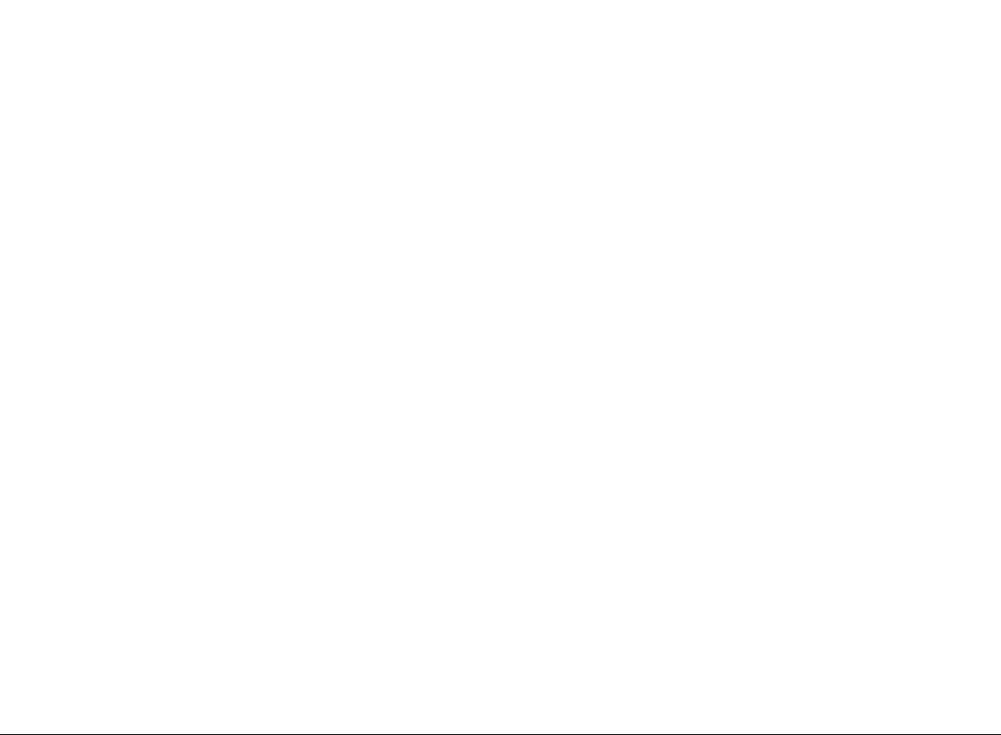
in Figure 4 of the main text, and gradiometer locations with peak signal.) (B) Mean regression coefficients when cue direction and HEOG signal are both used to predict left-lateralized signal. Error bars represent ± 1 SEM across subjects; * p < 0.05, ** p <